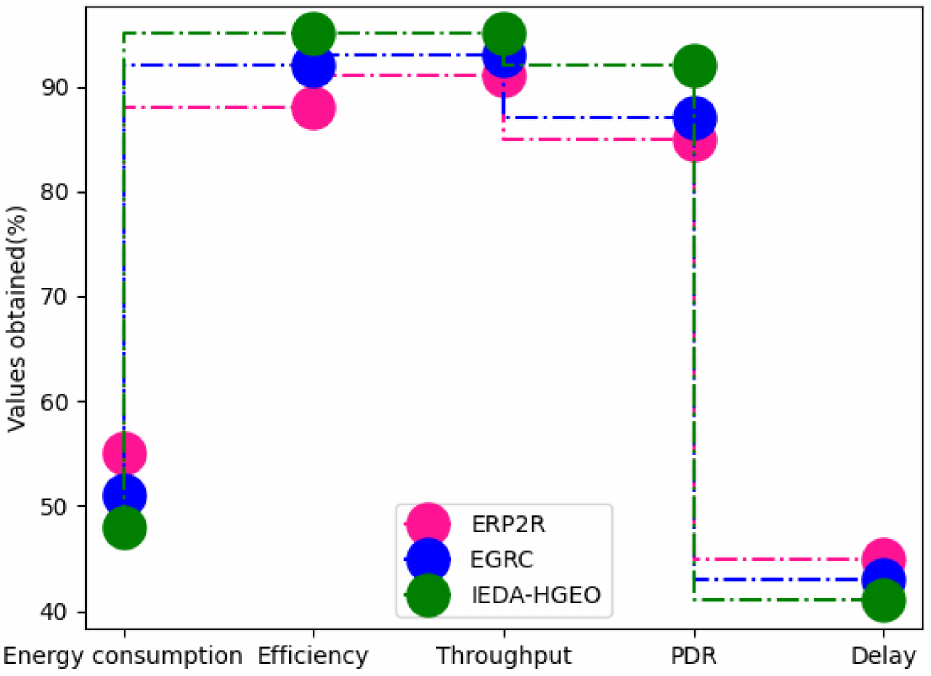
Figure 6. Parametric comparison between proposed and existing